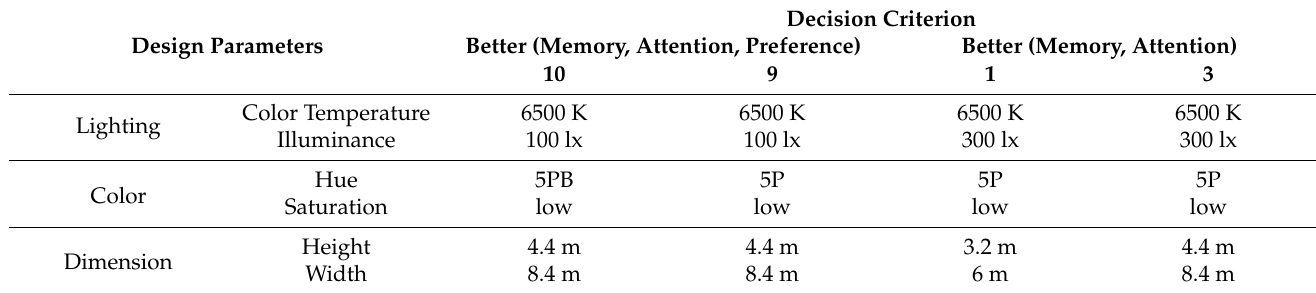
Table 6. Design configurations for the best